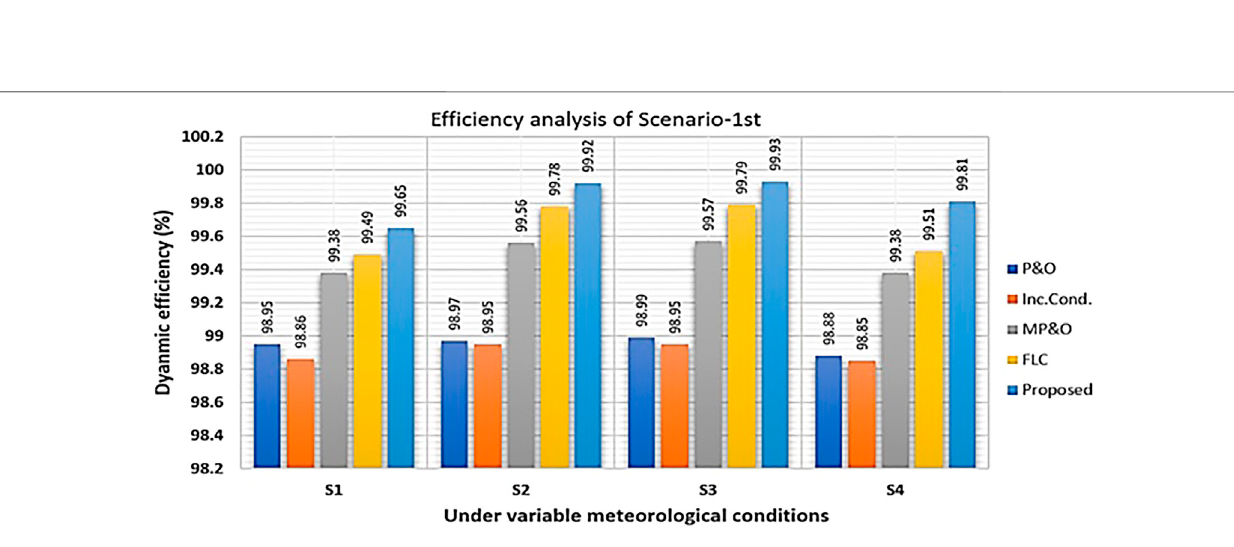
Table 3 . Output power of P 0_S11 = 2.55 kW with output voltage